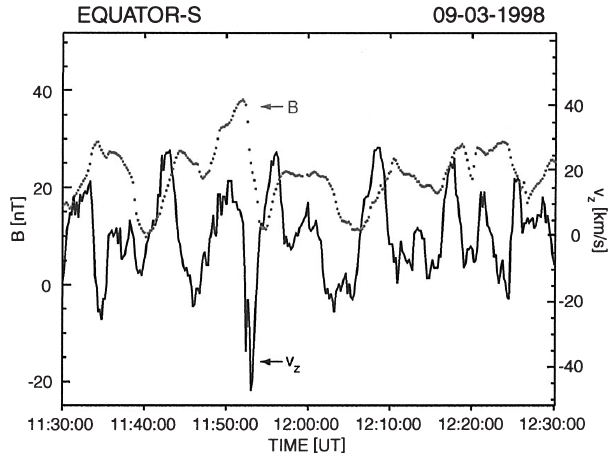
Fig. 8. Phase relation between magnetic field magnitude ( dotted line ) and field-parallel flow component ( full line ) as observed by Geotail during the conjunction with Equator-S on 9 March 1999. v z is directed equatorward when B is rising, i.e. when the plasma pressure south of the equator is decreasing and vice versa